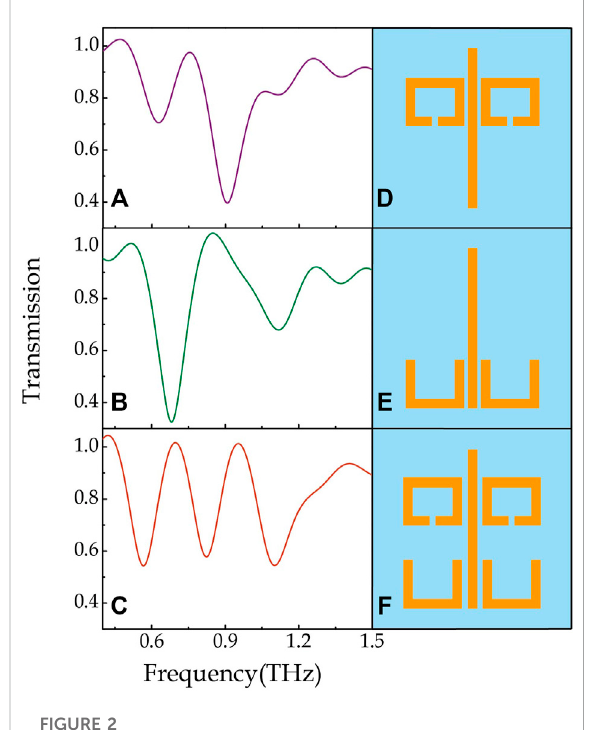
FIGURE 2 Simulated amplitude transmission spectra of (A) “ CWR + DSRR ” , (B) “ CWR + DUR ” , and (C) D-EIT metasurfaces under the y -polarized incidences. (D – F) Schematics of the unit cells corresponding to (A – C) , respectively.